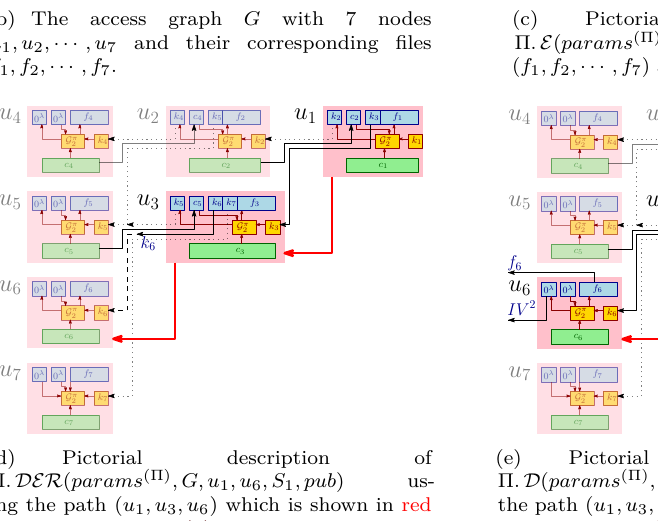
Pictorial description of Π . E ( params (Π) ,G,f ), where f = ( f 1 ,f 2 , ··· ,f 7 ) and G is shown in 22(b).